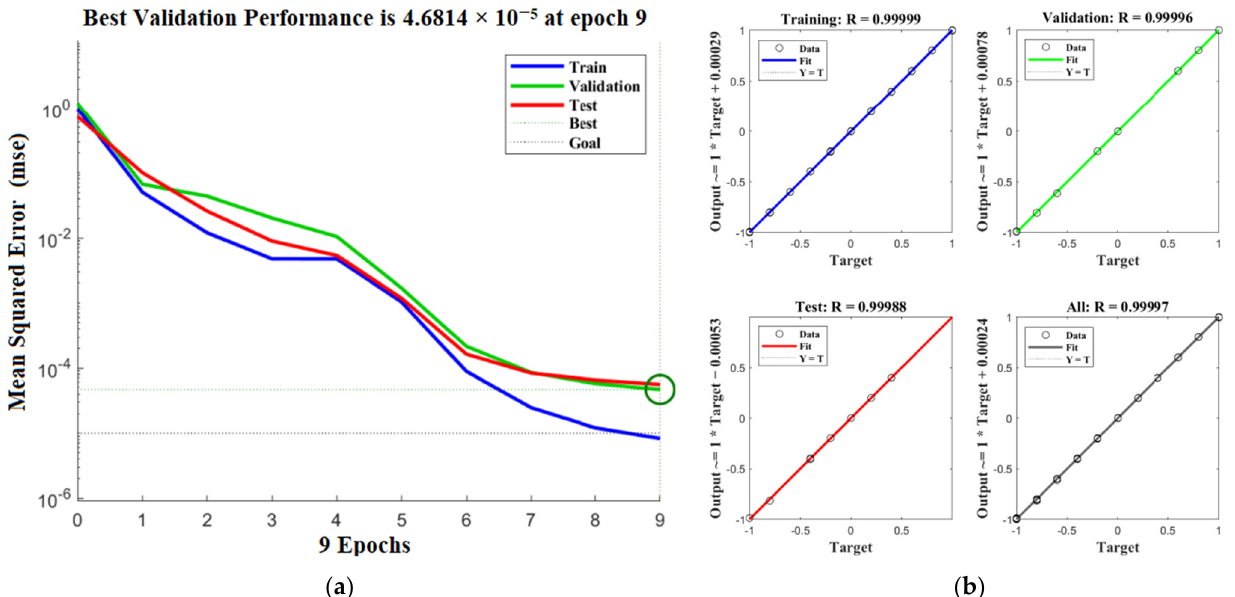
Figure 5. Simulation curve. ( a ) Performance curves of model error; ( b ) Regression curves of model error.